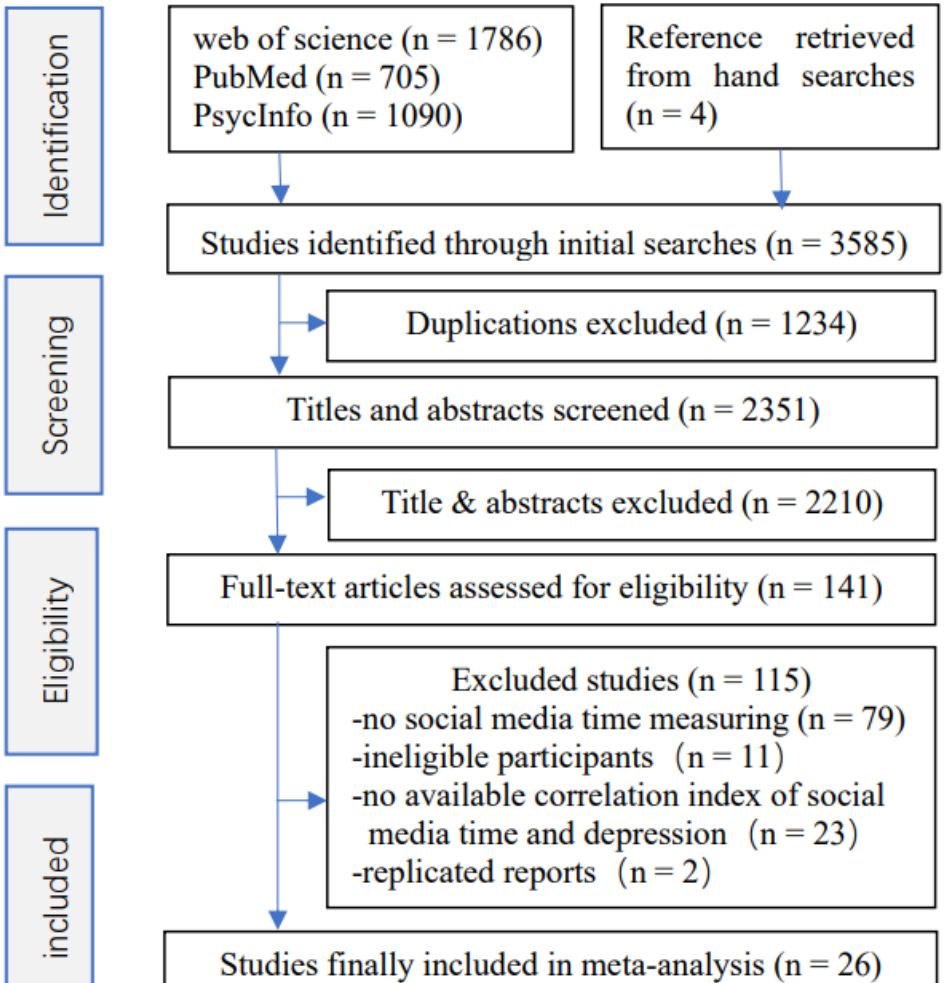
Figure 1. Flow chart of article screening process.